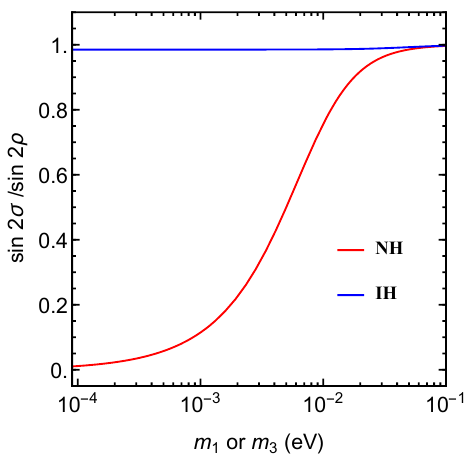
in the NH case or m in 1 3